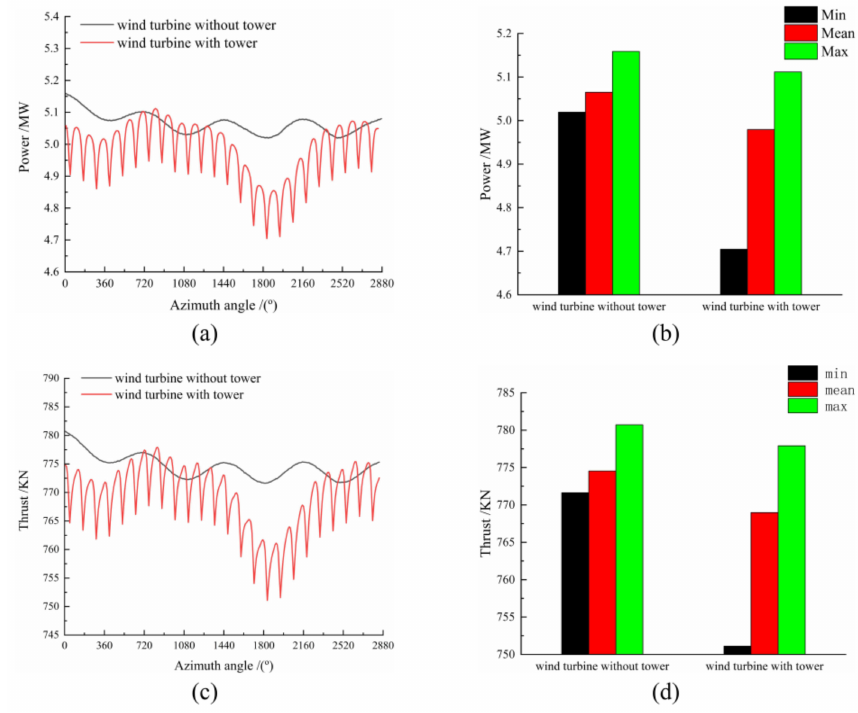
Figure 13. Total aerodynamic comparison of pitch motion; ( a ) Power versus azimuth angle; ( b ) Ex- treme and average values of power; ( c ) Thrust versus azimuth angle; ( d ) Extreme and average values of